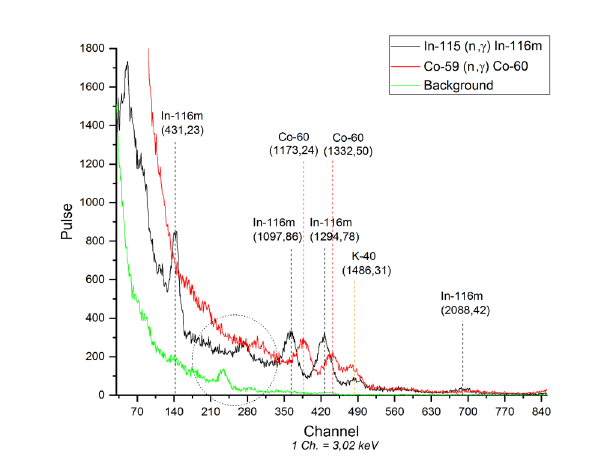
Fig. 9. The gamma spectra from activated 59 Co and 115 In samples and background